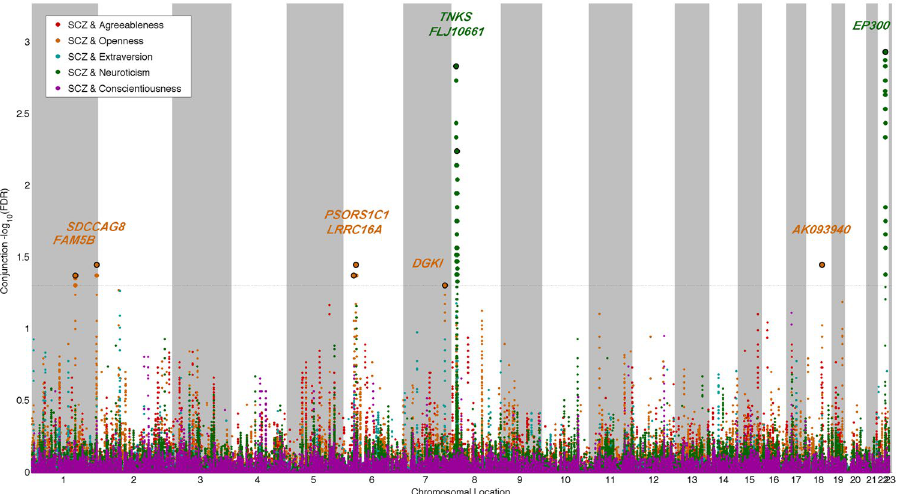
Figure 3. ‘Conjunction FDR Manhattan plot’ of conjunction (FDR < 0.05) values for schizophrenia (SCZ) and agreeableness, openness, extraversion, neuroticism and conscientiousness. SNPs with conjunction FDR < 0.05 (i.e., − log 10 FDR > 1.3) are shown with enlarged data points. A black circle around the enlarged data points indicates the most significant SNP in each LD block and this SNP was annotated with the closest gene which is listed above the symbols in each locus. The figure shows the localization of the ‘conjunctional loci’, and further details are provided in Table